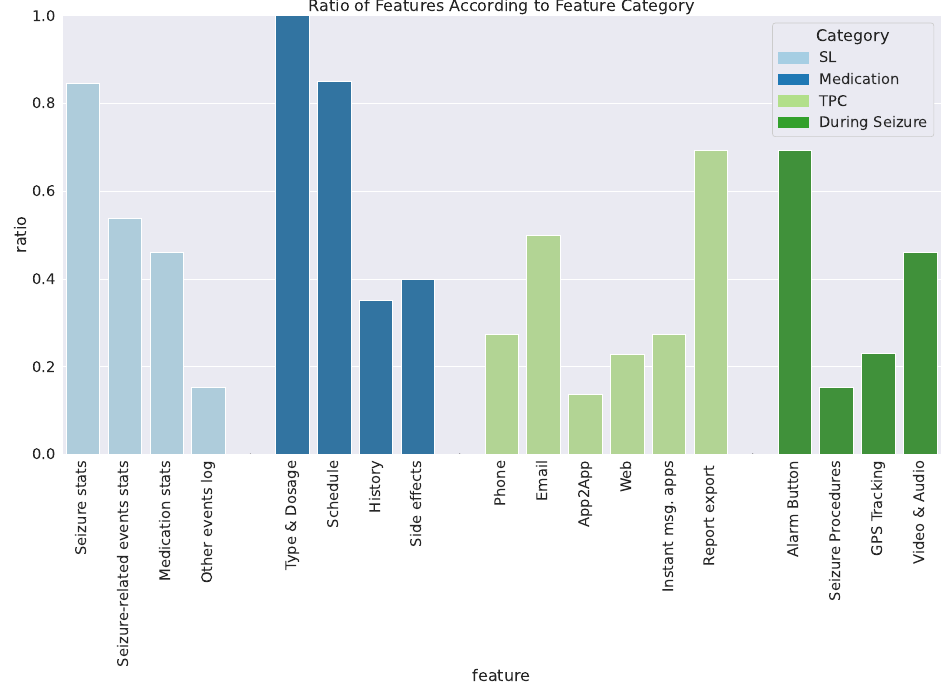
Figure 3. Ratio of apps that provide a particular feature. Note: the ratios are computed within the number of apps that contain the corresponding category of